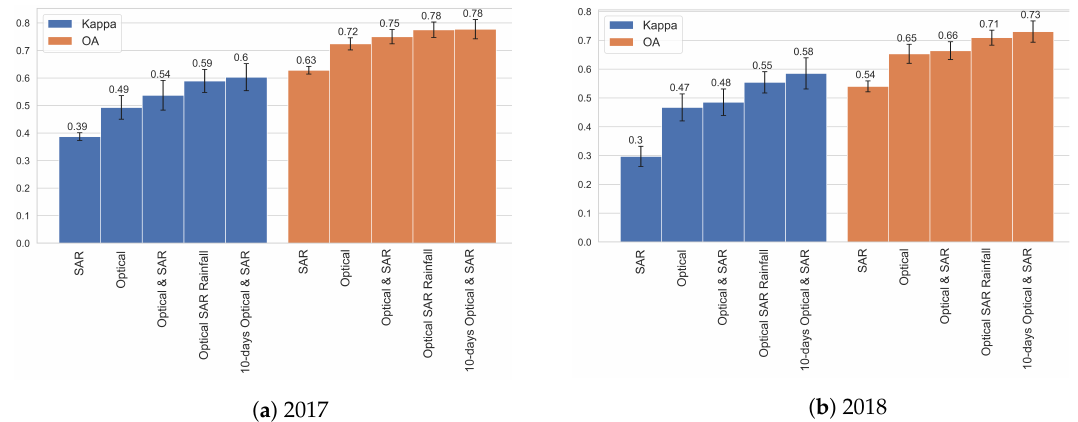
Figure 5. Performance for each scenarios.The orange and blue bars correspond to Overall accuracy and Kappa respectively. ( a ) illustrates the results obtained in 2017 and ( b ) corresponds to those obtained in 2018.